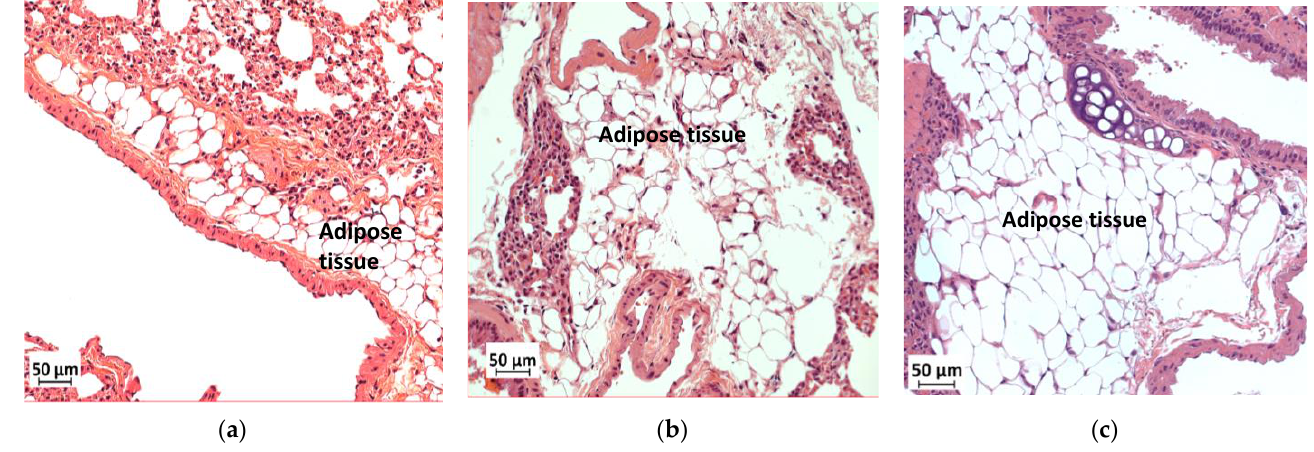
Figure 10. Effect of slc7a8 deletion on lipid accumulation in the lungs. H&E-stained lung sections showed the accumulation of adipose tissue in the lungs, which was greater in WTHFD ( c ) than in KOHFD ( b ) and WTCD ( a ). Magnification = 20×. Scale bar = 50 µm. 3.10. Deficiency in Slc7a8 Reduces White Adipose Tissue Inflammation in DIO Immunohistochemical staining for F4/80, a mouse macrophage marker, was per- formed to assess the presence of macrophages in pWAT, mWAT, iWAT and brown adipose tissue. Deletion of slc7a8 significantly decreased macrophage infiltration (indicated by black arrows) in the pWAT (Figure 11c; p < 0.01), mWAT (Figure 11h; p < 0.05), and iWAT (Figure 11k; p < 0.01) of KOHFD (Figure 11a,f,i) compared with those of WTHFD (Figure 11b,g,j). No significant difference was observed in the brown adipose macrophage inflammation profile (Figure 11n) between WTHFD (Figure 11m) and KOHFD (Figure 11l). Figure 11d,e shows the negative controls for KOHFD and WTHFD, respectively, in perigonadal adipose tissue.